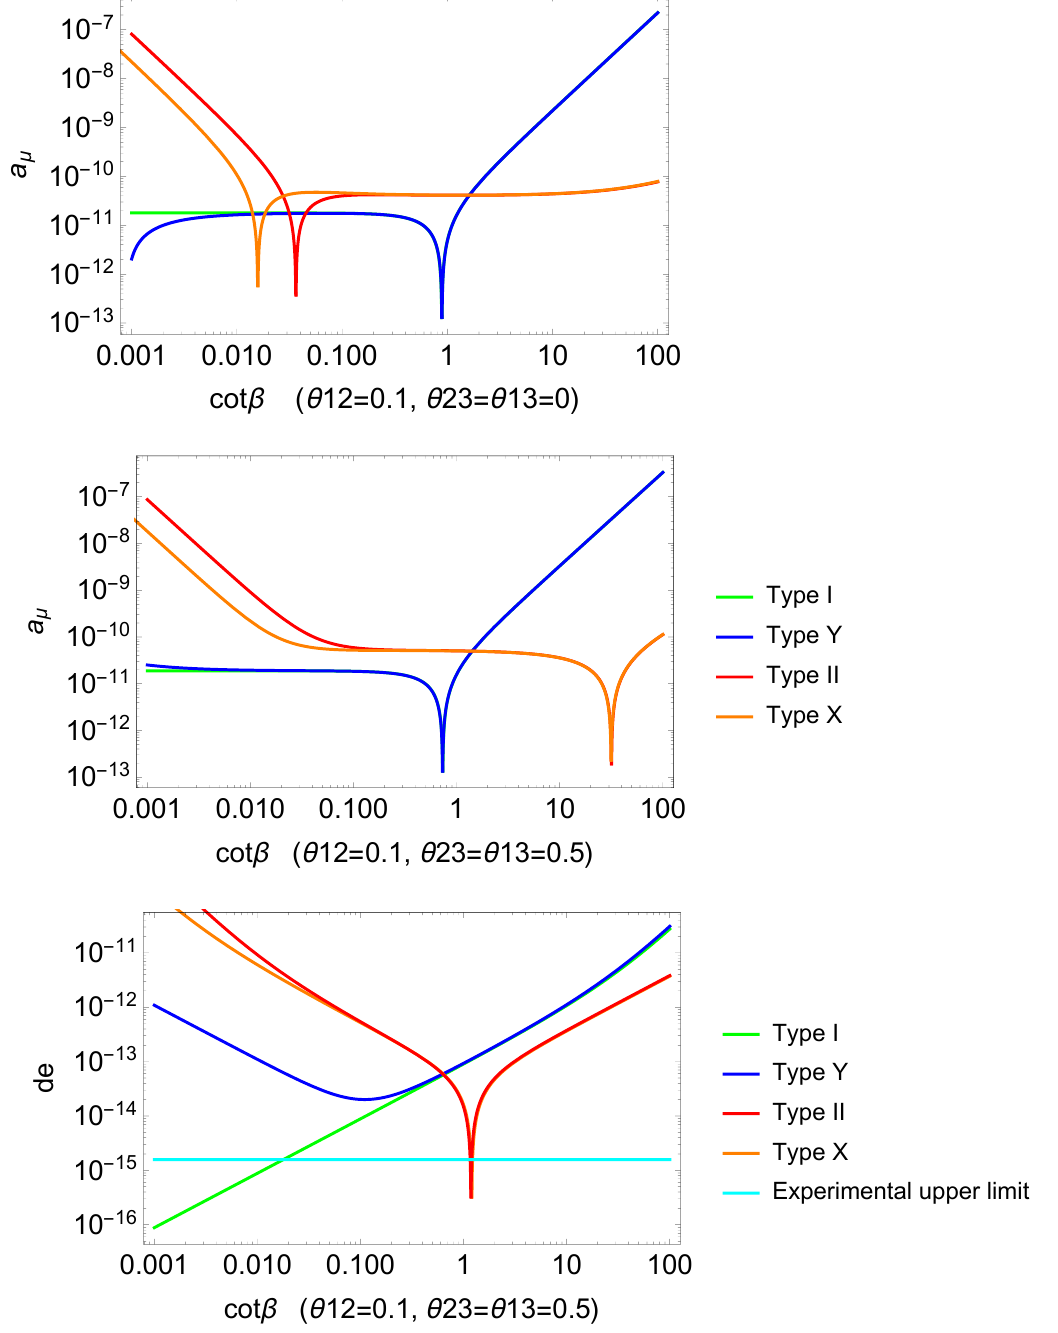
Figure 6 . a (cid:22) (top) and d e (bottom) contribution in di(cid:11)erent 2HDM Types for (cid:12)xed values of masses ( m h = 200 ; 300 GeV) in the CP-conserving limit (left) and in the presence of CP-violation 2 ; 3